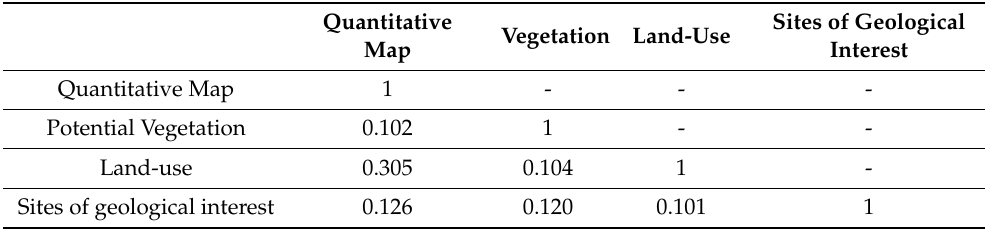
Table 3. Pearson’s correlation coefficient results using the geodiversity index map, vegetation, land - use, and sites of geological interest in Miguel Pereira municipality.